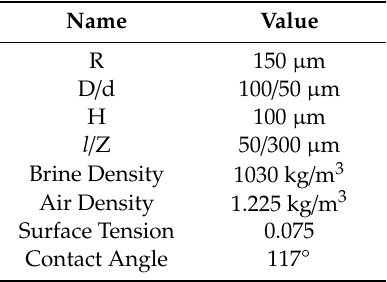
Figure 2. Diagram of the inertial switch structure model. Table 1. The simulation model parameters.